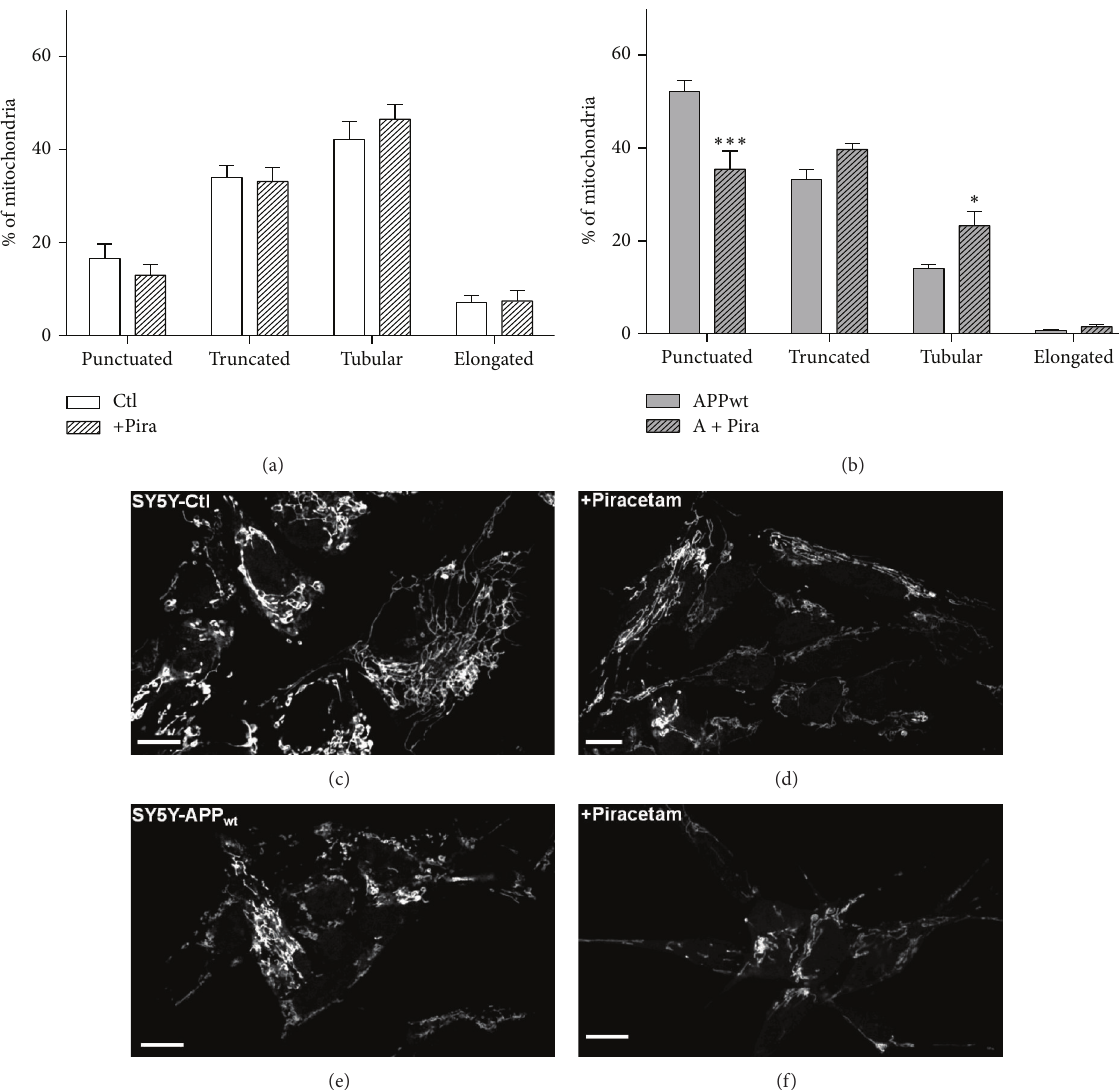
Figure 4: Piracetam improves mitochondrial dynamics in a cell model of early sporadic Alzheimer’s disease. (a) Under normal conditions, piracetam (Pira) shows no effect in SH SY5Y Ctl cells but (b) shifts mitochondrial fragmentation induced by an additional APP copy back to baseline conditions. SH-SY5Y cells were seeded and incubated for one day. Afterwards, incubation was started with 1mM piracetam (Pira). After 72 hours, cells were stained and fixed for analysis of mitochondrial dynamics. ((c), (d)) Representative pictures of SH-SY5Y Ctl and ((e), (f)) SH-SY5Y APPwt cells treated with piracetam; scale bar represents 10 𝜇 m. Data are represented as mean ± SEM; Two-Way ANOVA with Bonferroni’s posttest ( ∗ 𝑝 < 0.05 , ∗∗∗ 𝑝 < 0.001 compared to untreated control cells); 𝑛 = 7